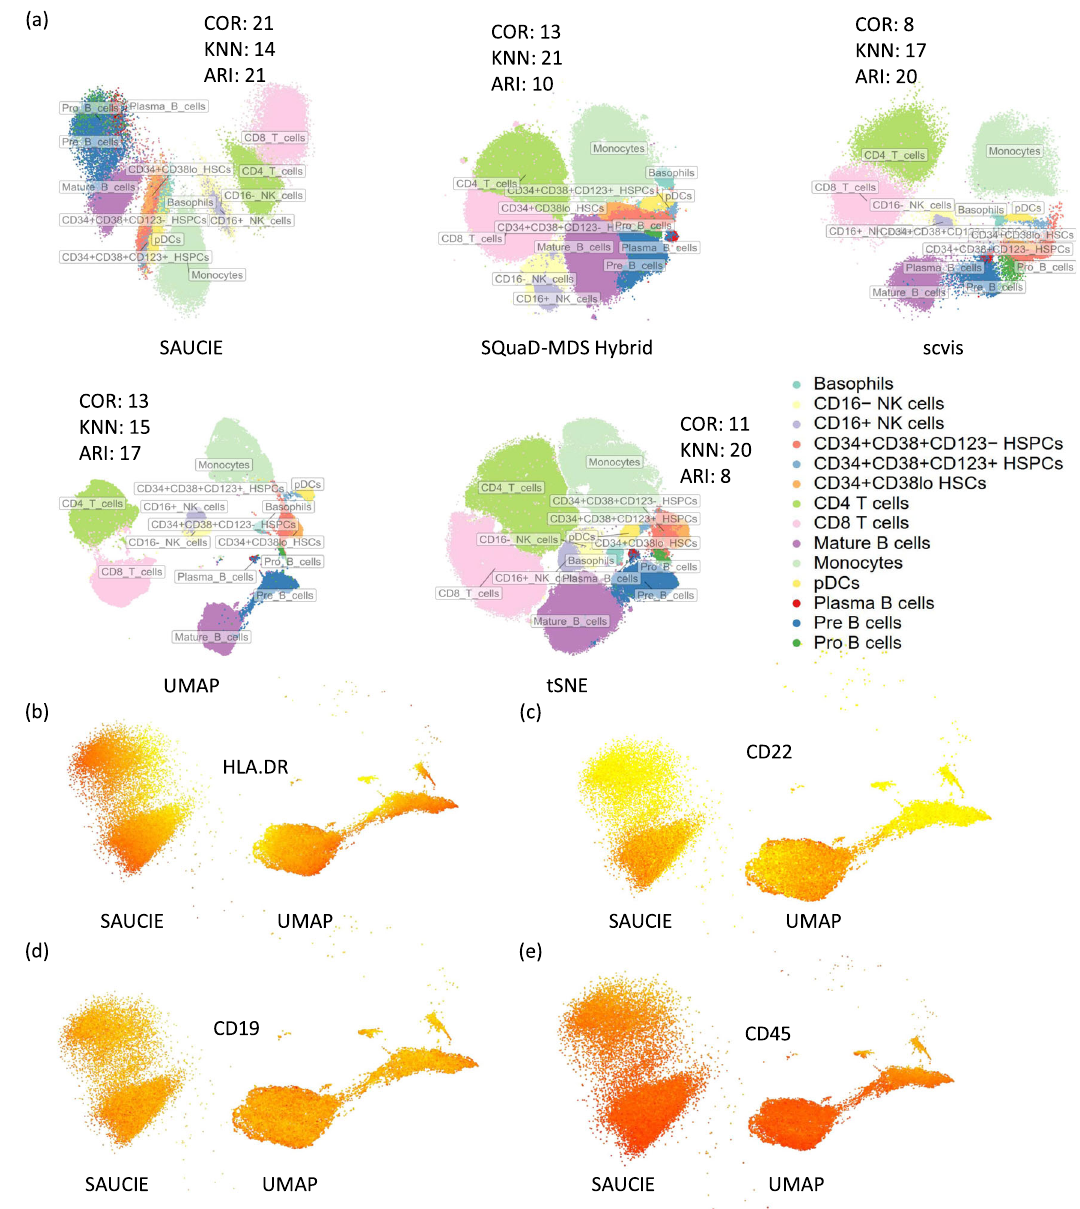
Fig. 4 | Visualizing DR results for theLevine32 dataset. a Visualization of the DR results of several top and popular methods on the Levine32 dataset, with cells colored by their cell types. The COR, KNN and ARI accuracy metrics, for each method,werealsolabeledbesideeachplot. b , e VisualizationoftheDRresultsfrom